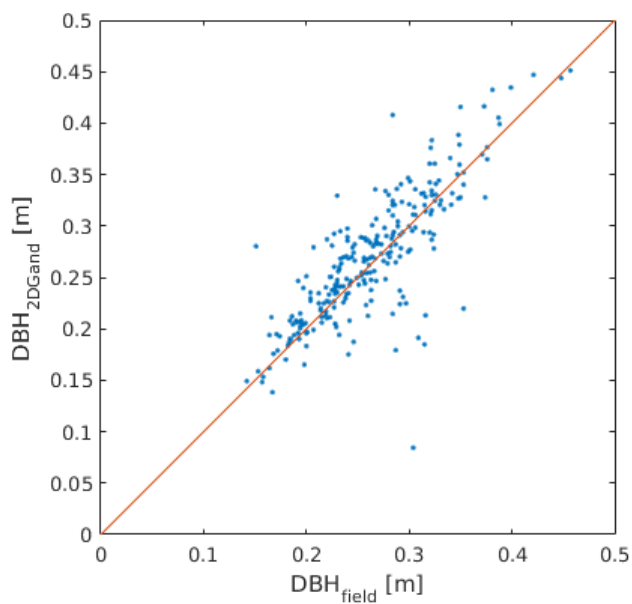
Figure 13. Scatter plot of DBH estimated by the most successful method, 2DGand, vs. field measured values. The red line marks 1:1.